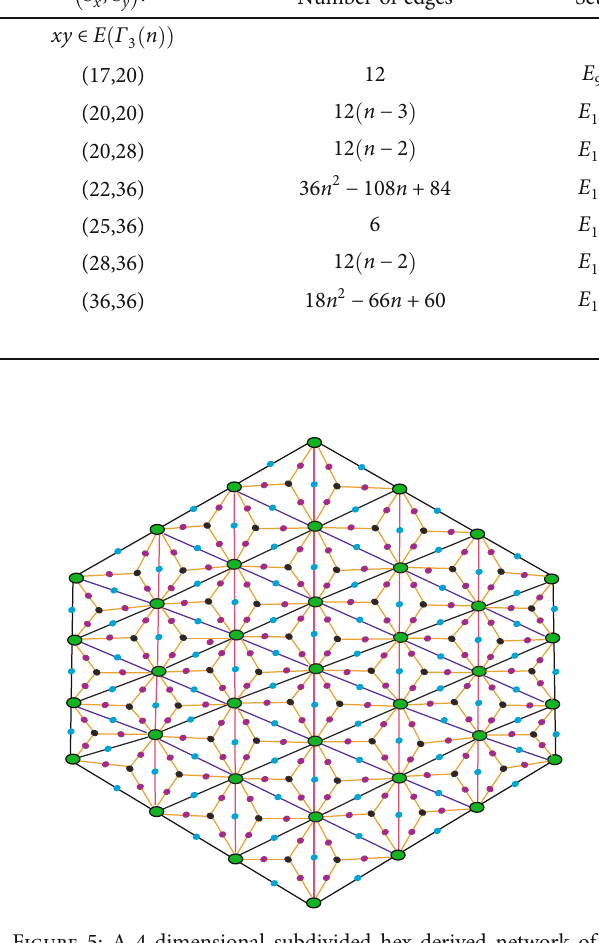
Figure 5: A 4-dimensional subdivided hex-derived network of a fi rst kind Γ 4 Þ 1 ð